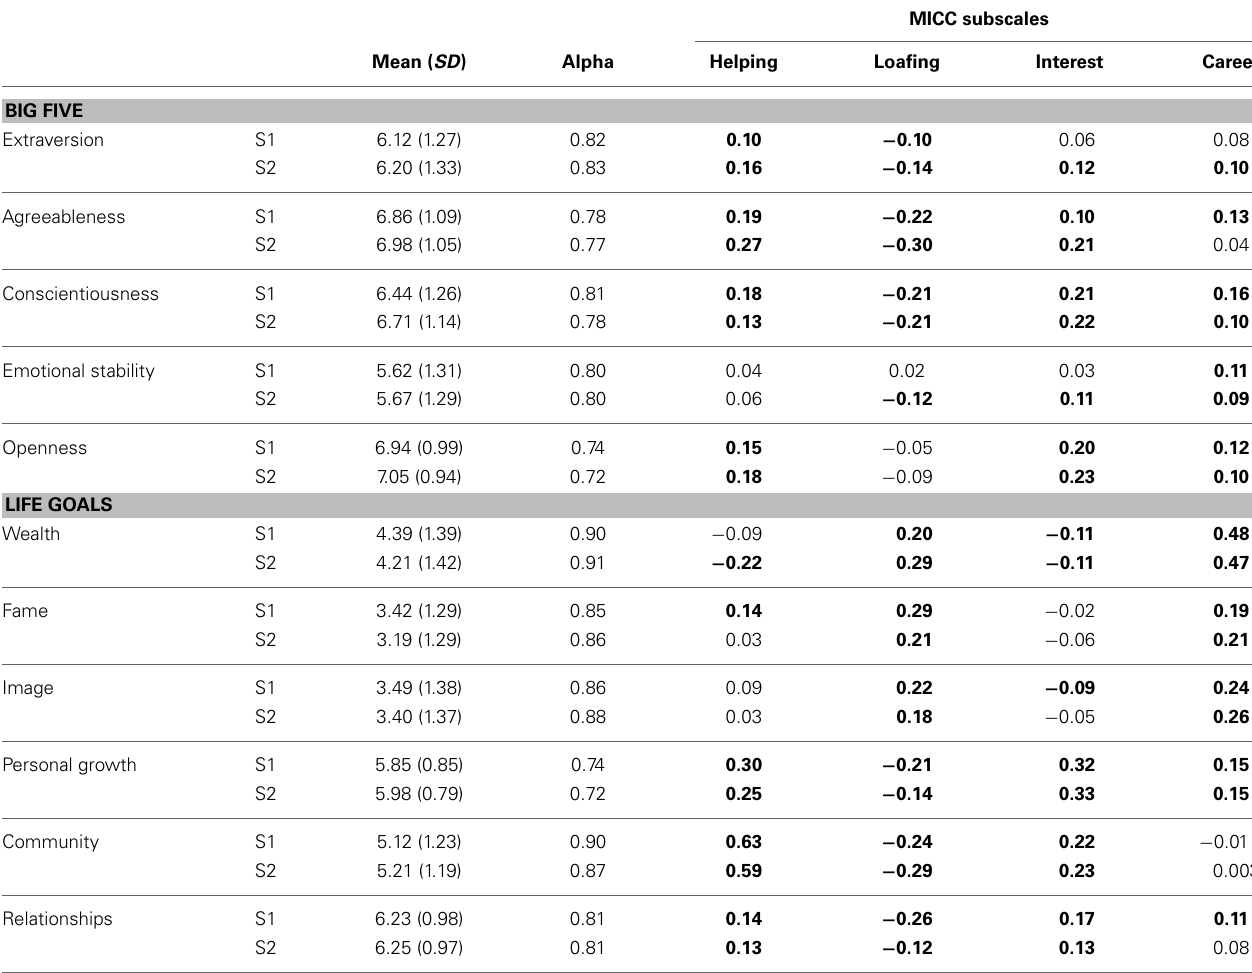
Table 3 | Cronbach alphas, means, standard deviations for personality traits and life goals, and their zero-order correlations with the MICC scales in Sample 1 (S1, N = 989) and Sample 2 (S2, N =